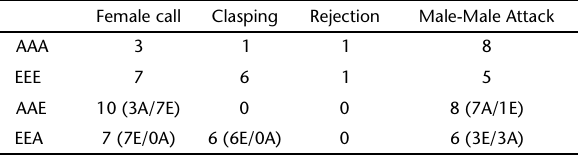
Table I. Number of trials in which behaviors occurred (from total ten trials per row). (AAA) Female A. suina with two conspecific males; (EEE) female E. weijenberghi with two conspecific males; (AAE) female A. suina with a male A. suina , and a male of E. weijenberghi ; (EEA) female E. weijenberghi with a male of E. weijenberghi and a male of A. suina . Within parenthesis is given the distribution of behavior by